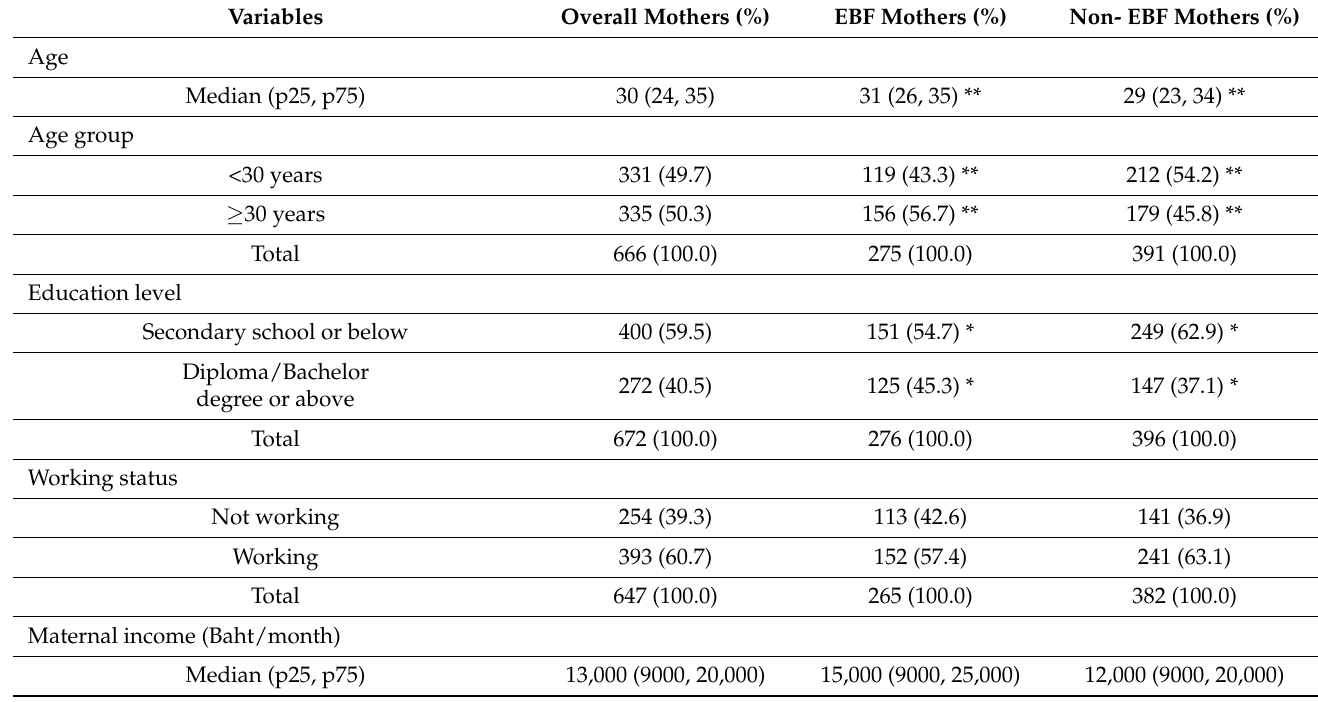
Table 1. Comparing the six-month exclusive breastfeeding (EBF) by personal attributes .